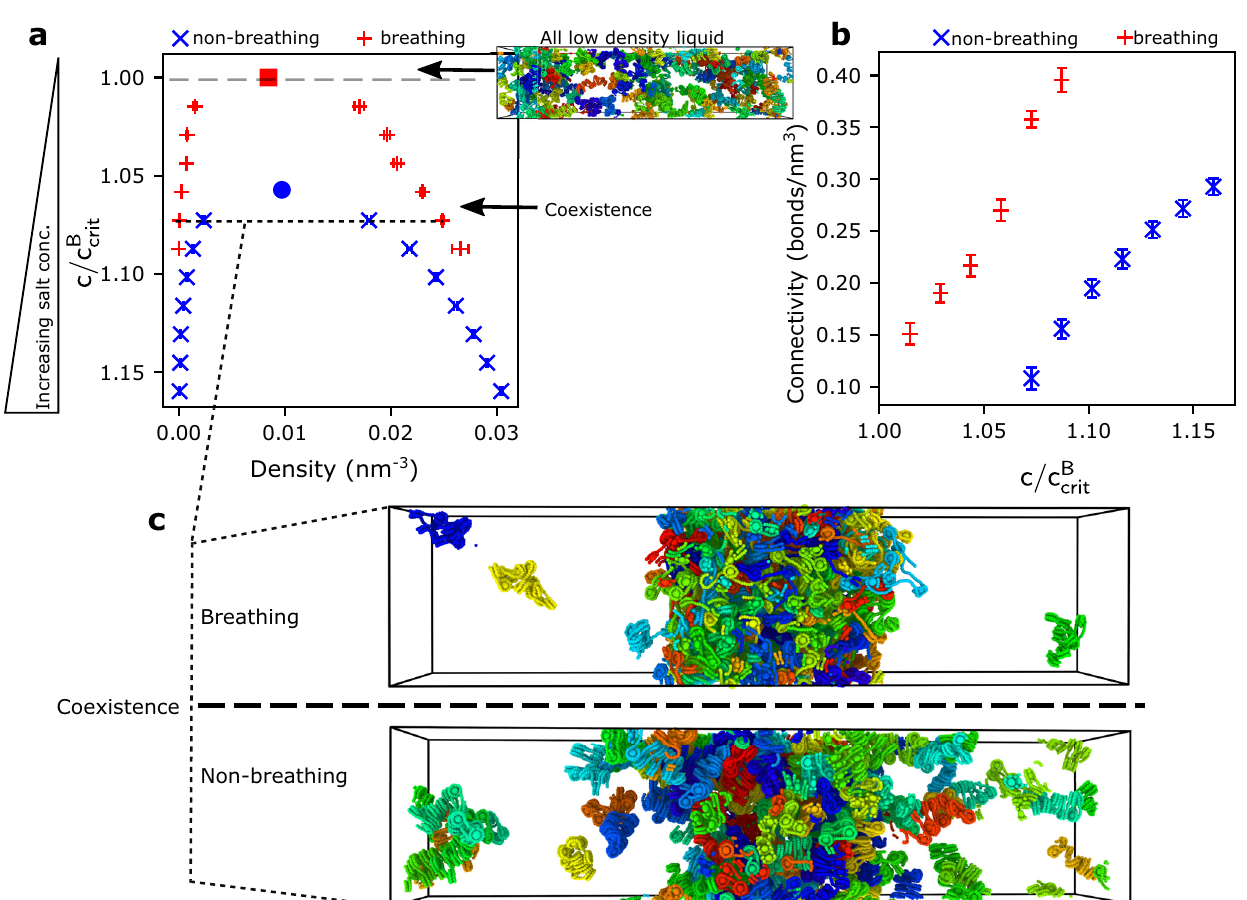
Fig. 6 Impact of nucleosome breathing on the phase behavior of chromatin. a Phase diagram of a solution of 12-nucleosome chromatin arrays exploring the space of decreasing concentration of NaCl (vertical axis, C ) versus density (horizontal axis). The data points (blue: non-breathing, red: breathing) represent coexistence points, i.e., the densities of the chromatin-diluted (left branch) and chromatin-enriched (right branch) coexisting liquid phases at a given monovalent salt concentration. The density is de fi ned as the number of chromatin molecules per unit of volume in nm − 3 . Statistical errors, mean ± s.d., are shown as bands; these were obtained from the density pro fi le curves (Supplementary Fig. 5) by comparing n = 100 density values within the plateau characterizing each phase. The region above the coexistence curve is the “ one-phase region ” , where the NaCl concentration is too low to screen DNA – DNA electrostatic repulsion and enable the attractive nucleosome – nucleosome interactions, needed for LLPS (see top snapshot of a well-mixed low-density liquid). A representative simulation snapshot of the well-mixed low-density liquid for chromatin with non-breathing nucleosomes is shown. Each independent 12-nucleosome array within the solution is colored differently to aid visualization; the DNA beads are shown as small spheres and each nucleosome histone core with one larger sphere (as described in Fig. 1 — level 3). The region below the coexistence curve represents the “ two-phase region ” where chromatin demixes into a condensed (chromatin-enriched) and a diluted (chromatin-depleted) liquid phase. The maximum in the coexistence curve represents the critical point: if the NaCl concentrations exceed the critical value, LLPS occurs spontaneously. The vertical axis has been normalized by the = 0.069mol/L of NaCl. The critical salt concentration for critical salt concentration for chromatin with breathing nucleosomes ( C = C B ), where C B crit crit = 0.073mol/L. b Connectivity of the condensed liquid formed by chromatin with non-breathing (blue) chromatin with non-breathing nucleosomes is C NB crit versus breathing (red) nucleosomes. The connectivity is de fi ned as the mean number of connections that chromatin arrays within the condensed liquid form (i.e., the number of distinct chromatin arrays that a reference array is in contact with, considering any two nucleosomes within a center-to-center distance shorter than 110 Å ) multiplied by the density of the condensed phase. Statistical errors, mean ± s.d., are shown as bands; these were obtained by comparing the values among from n = 300 independent con fi gurations. c Representative simulation snapshots of the phase-separated liquids formed by chromatin with ¼ 1 : 073 (i.e., C = 0.074mol/L of NaCl). The 12-nucleosome arrays in the breathing (top) versus non-breathing (bottom) nucleosomes at a value of C = C B crit snapshot are depicted as described in a